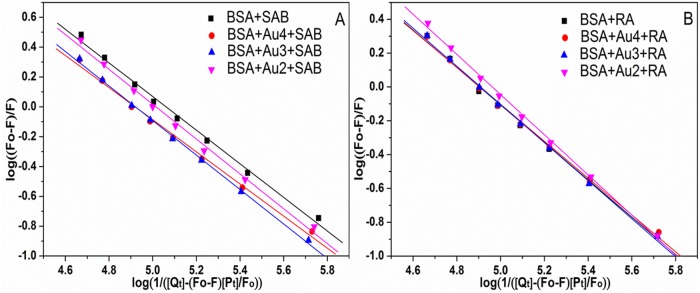
Plots for calculating the binding constants and the stoichiometry of binding of BSA–drug systems without and with Au NPs.Double logarithmic curves of SAB (A) and RA (B) quenching BSA fluorescence in the absence of Au NPs (square) and in the presence of Au4 (circle), Au3 (up triangle) and Au2 (down triangle). CBSA = 5.0 × 10-6 mol L-1, the concentration of Au NPs was 10.0 × 10-11 mol L-1, λ
ex = 280 nm, pH = 7.40.